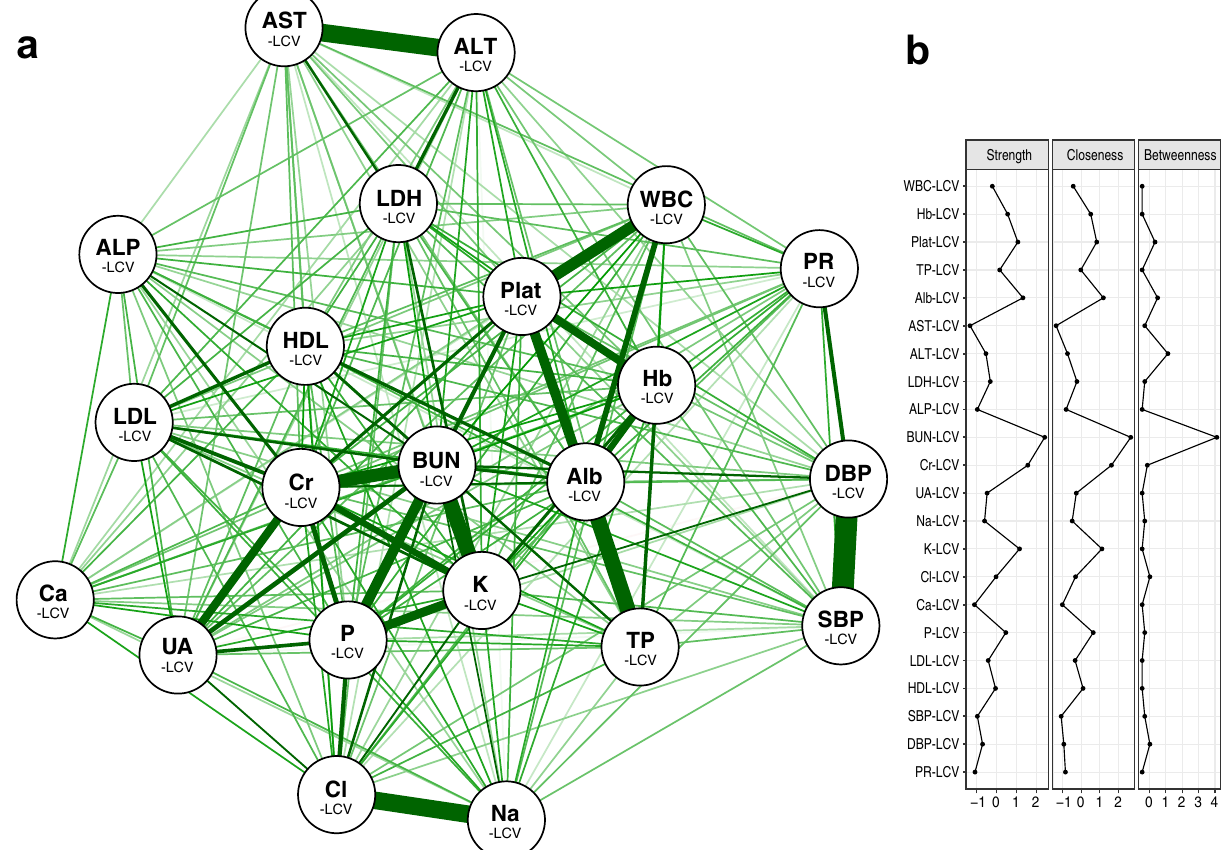
Figure 3. Network structure of physiological regulation. ( a ) The structure of the regulatory systems involving the 22 biomarkers can be visualized as a two-dimensional diagram. Each node labeled a X-LCV represents a regulatory system of biomarker X or its dysregulation. The thickness and relative length of the lines connecting the nodes express the strength of the correlation. Green color denotes a positive correlation. ( b ) Centrality plot for the network depicting the betweenness, closeness, and strength of each